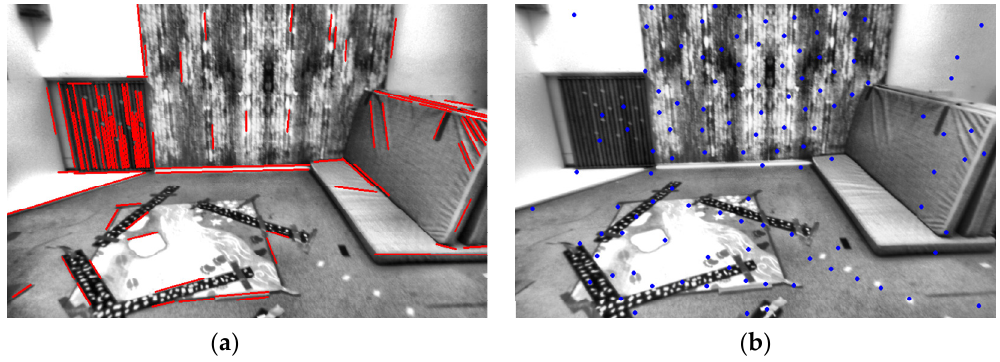
Figure 9. V1_01_easy visual feature extraction: ( a ) line features extraction, ( b ) point features extraction.